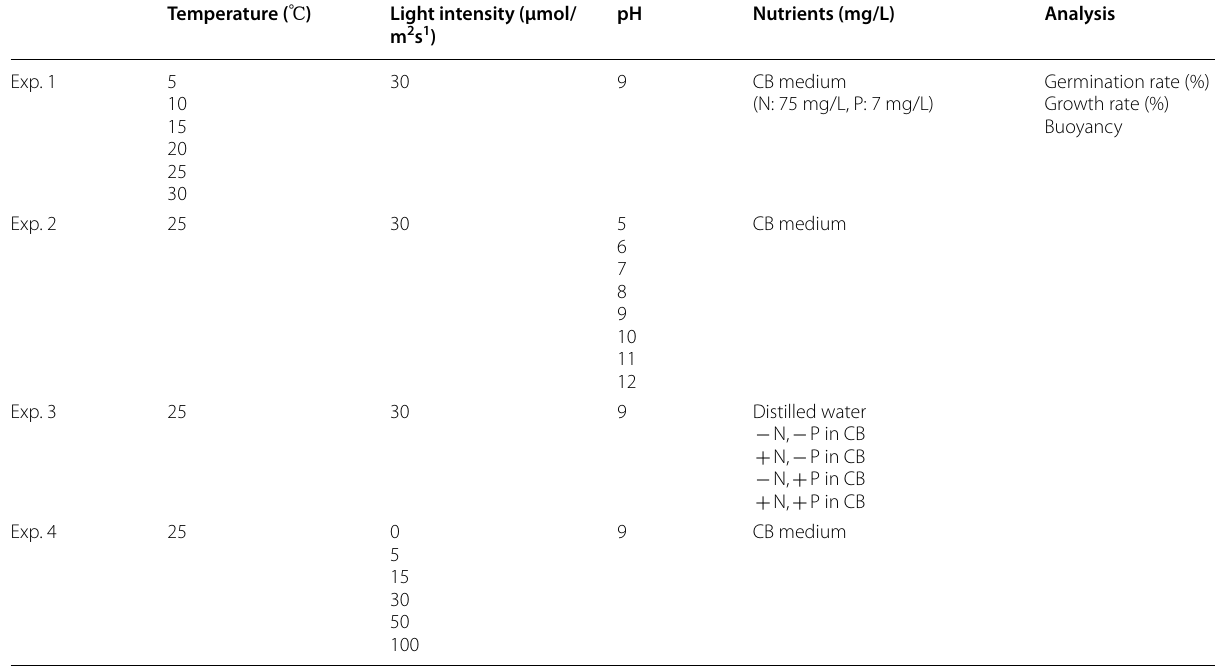
Exp experiment, CB Cyanobacteria